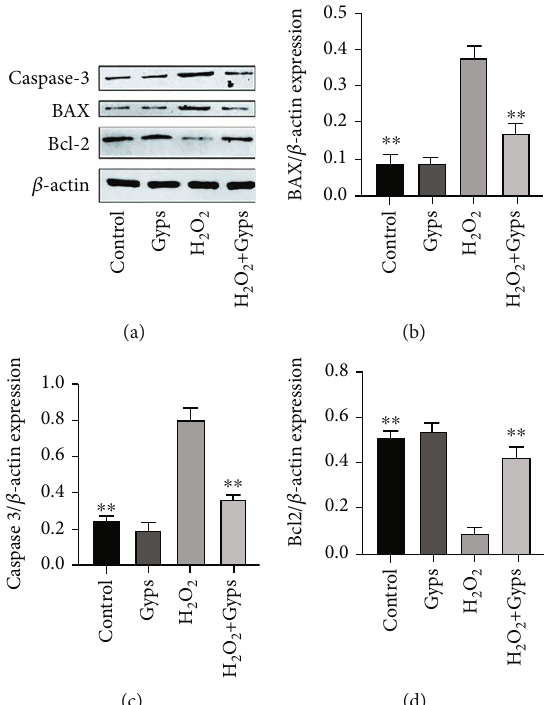
Figure 11: Gypenosides can protect the apoptosis induced by H expression of caspase-3 and BAX increased, and the expression of Bcl-2 decreased after H group, the expression of caspase-3 and BAX decreased, while Bcl-2 increased in preintervention of gypenosides was further increased. These bands are quanti fi ed by densitometry and then normalized to the level of β -actin in the same sample. All proteins were expressed by the ratio of band density to β -actin band density. Three samples from each of the three GO donors were taken for the experiment. All detections are repeated 3 times, with 3 replicate wells each time ( ∗ as P < 0 : 05 and ∗∗ as P < 0 : 01 ; P < 0 : 05 means the di ff erence is statistically signi fi cant, and P value is analyzed by one-way